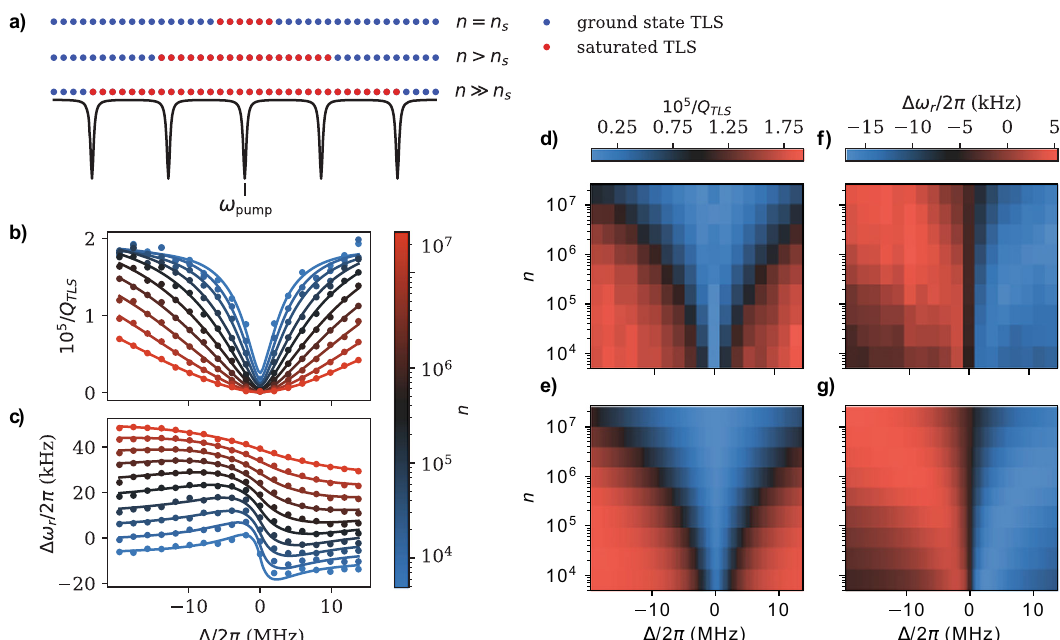
Fig. 2 Two-tone spectroscopy of the TLS ensemble. a Illustration of TLS saturation due to the pump. Near-resonant TLSs in the ground state can be excited by the SAW fi eld and the induce loss. Saturated TLSs do not contribute to the loss. At the single mode saturation phonon number n s , TLS loss is mitigated in the pump mode, while losses in other modes are only marginally affected. As the strength of the pump tone is increased, the spectrum of the saturated TLSs becomes wider, reducing loss substantially in nearby modes. In two-tone spectroscopy, a drive tone is applied at the pump mode and response in the other modes are measured as a function of detuning Δ and the number of pump phonons n . The TLS loss 1/ Q TLS is shown in b with fi ts to Eq. (3) (solid lines). The colour scale indicates the pump phonon number. Applying a detuned pump also induces a frequency shift in the probe mode, plotted in c with fi ts to Eq. (3) (solid lines) and a 5 kHz offset between traces. In d we plot the TLS loss as a function of detuning and pump phonon number, with the fi t shown in e . The corresponding plots for the frequency shift are shown in f , g . The frequency resolution in Δ in the measurement is given by the free spectral range of the resonator.